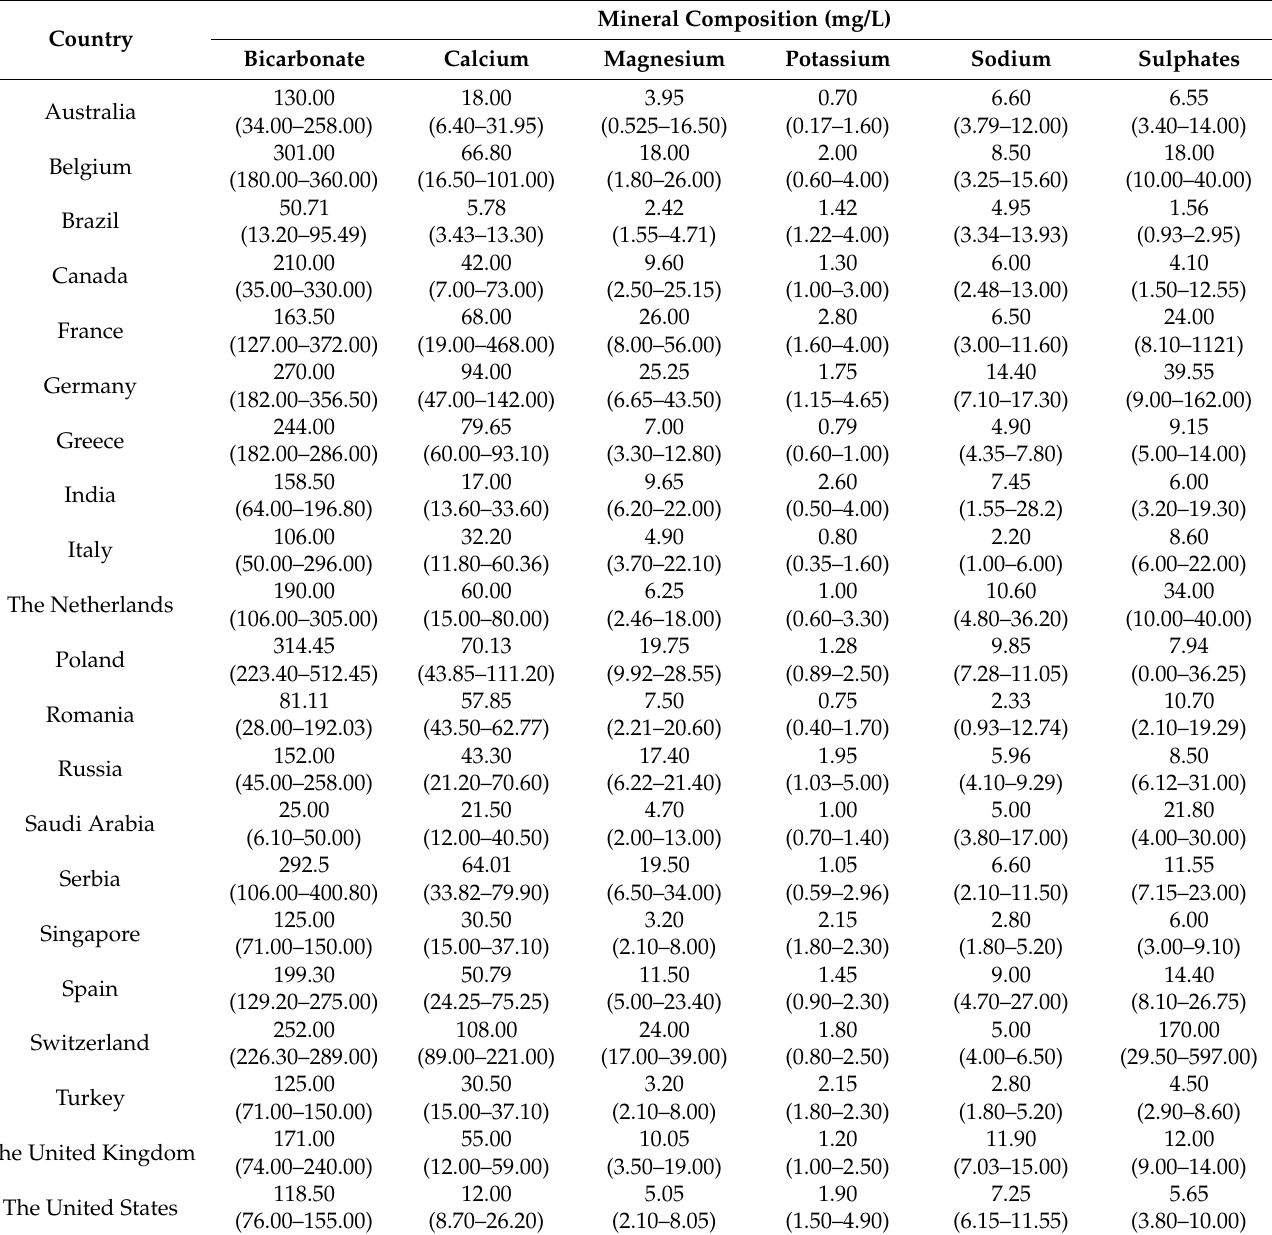
Table 1. The mineral composition (mg/L) of bottled still water expressed as median